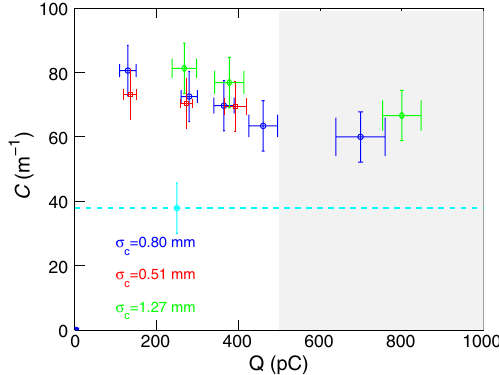
FIG. 10. Measured longitudinal-phase-space chirp C (cid:4) (cid:9) i = h z 2 i as a function of charge for three cases of laser h z 0 0 0 transverse rms size (cid:2) c on the photocathode surface. The hori- zontal dashed line represents the nominal chirp when the 3-ps- long Nd:YLF laser is used for photoemission. The shaded area represents the domain where the parabolic character of the temporal distribution was observed to be distorted and is con- sequently associated to a regime where a uniformly filled- ellipsoid bunch is not realized. The chirp associated to the electron bunch produced with the Nd:YLF laser was found to be independent of the charge and only one measurement (per- formed for Q ¼ 250 pC ) is